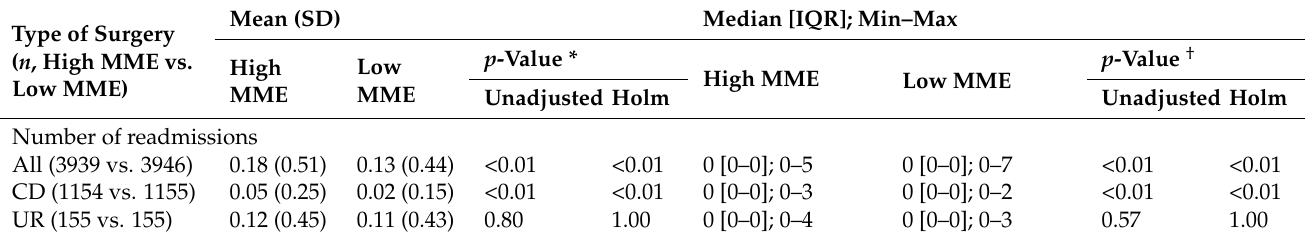
Table 4. Healthcare resource utilization: number of admissions, cumulative length of inpatient stay, cumulative length of inpatient stay if patient was admitted ever, average length of inpatient stay per admission during 180-day post-discharge